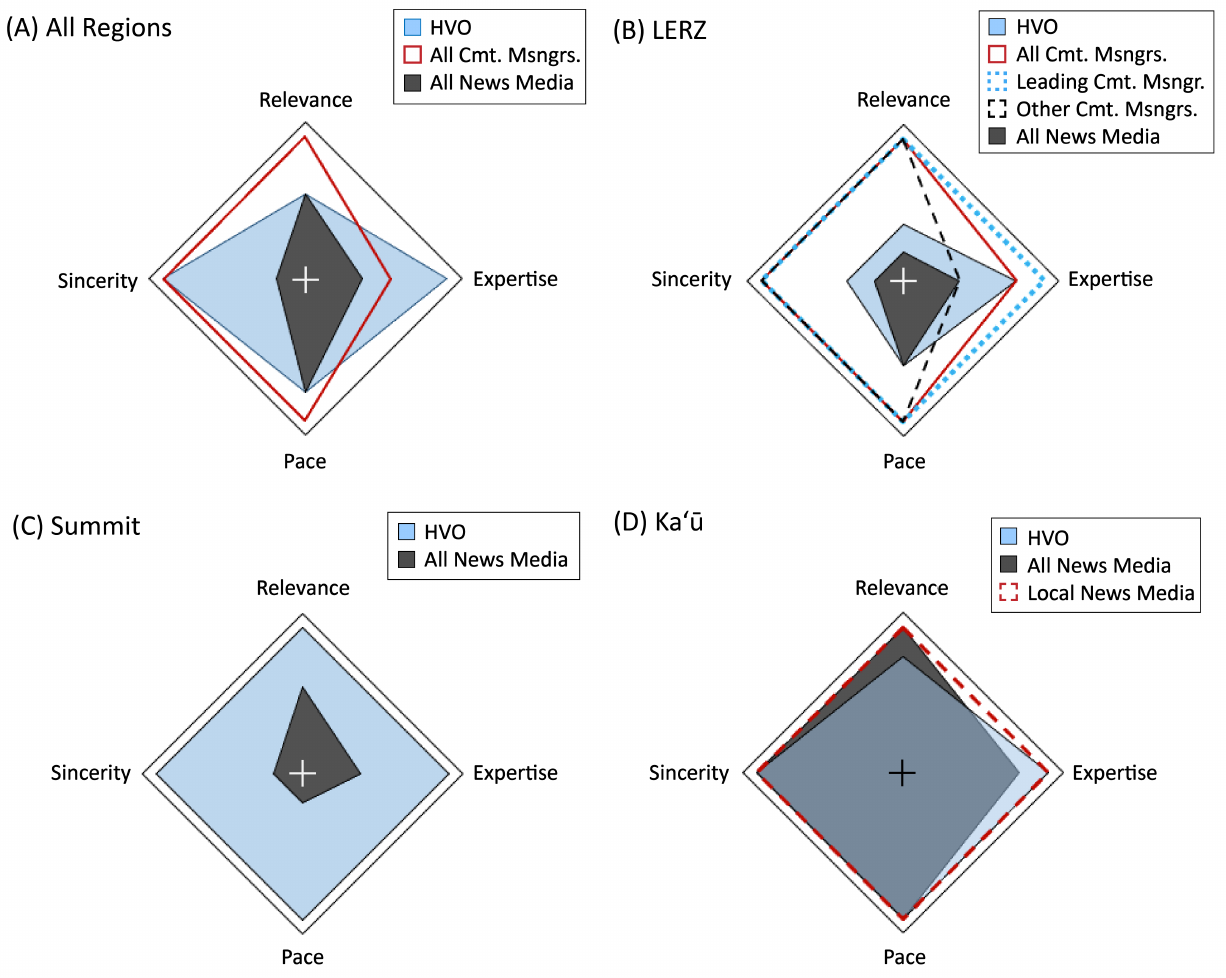
Figure 10: Radar charts comparing how participants’ perceptions of the three main sources/messengers of eruption information differed by participants’ region of residence. Panel [A] provides cumulative evaluations from all three hazard-impacted regions, while panels [B]–[D] provide evaluations from each region. In Panel [A], “All Cmt. Msngrs.” includes all groups and individuals considered to be community messengers. In Panel [B], “All Cmt. Msngrs.” includes all LERZ-based community messengers, while “Other Cmt. Msngrs.” includes all LERZ-based community messengers except for the community messenger group mentioned most frequently (“Leading Cmt. Msngr.”) by our interview and survey participants. Summit and Ka ‘ ¯u participants provided too few comments regarding community messengers for radar charts to be plotted for those regions. Themes are plotted on a five-point scale: 1 = “consistently negative,” 2 = “mostly negative,” 3 = “mixed,” 4 = “mostly positive,” 5 = “consistently positive.” In lieu of axis tick marks (to avoid cluttering), the center of each chart is indicated with a +. Plots are left blank for themes lacking qualitative commentary; markers or open outlines plot the scores for the remaining themes. For specific scores, the reader is referred to Supplementary Material